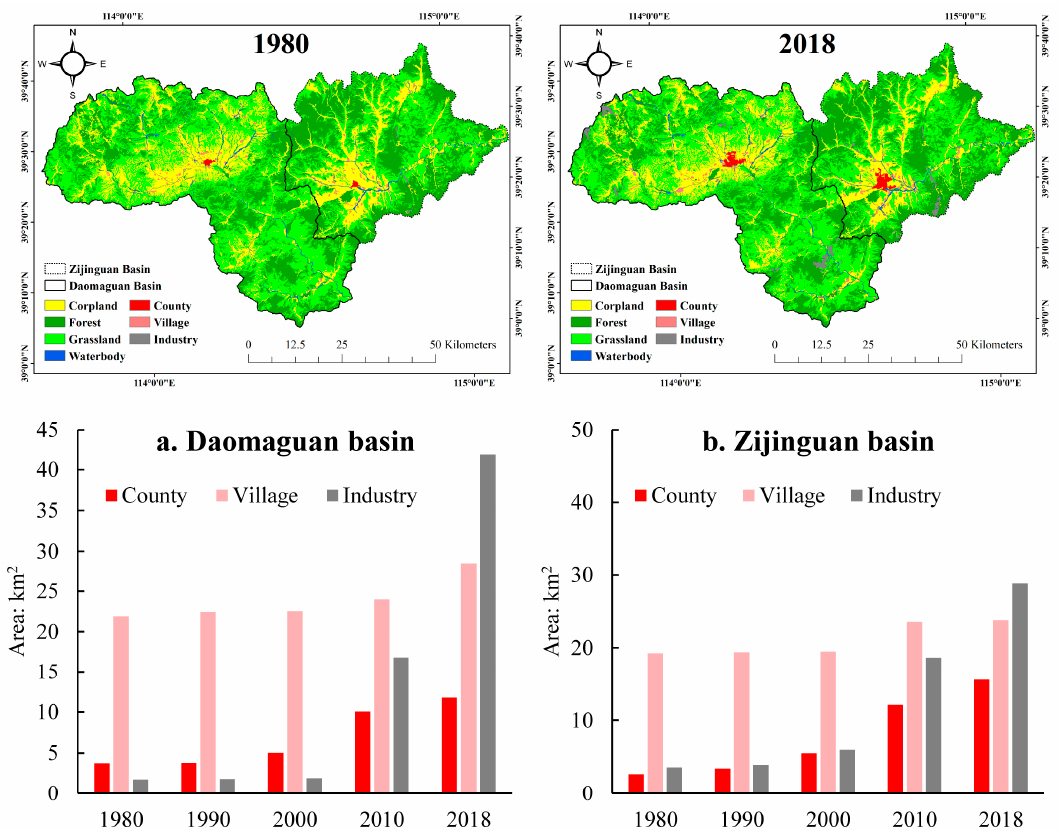
Figure 2. The characteristics and statistics of LULC from 1980 to 2018 in the study area: ( a ) the Daomaguan basin, ( b ) the Zijinguan basin.